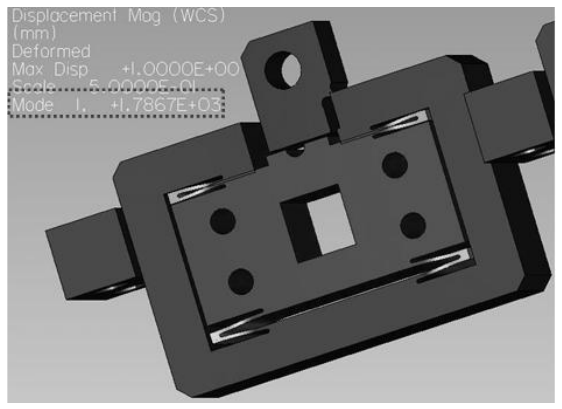
Figure 6. Dynamic FEA of the z -scanner.